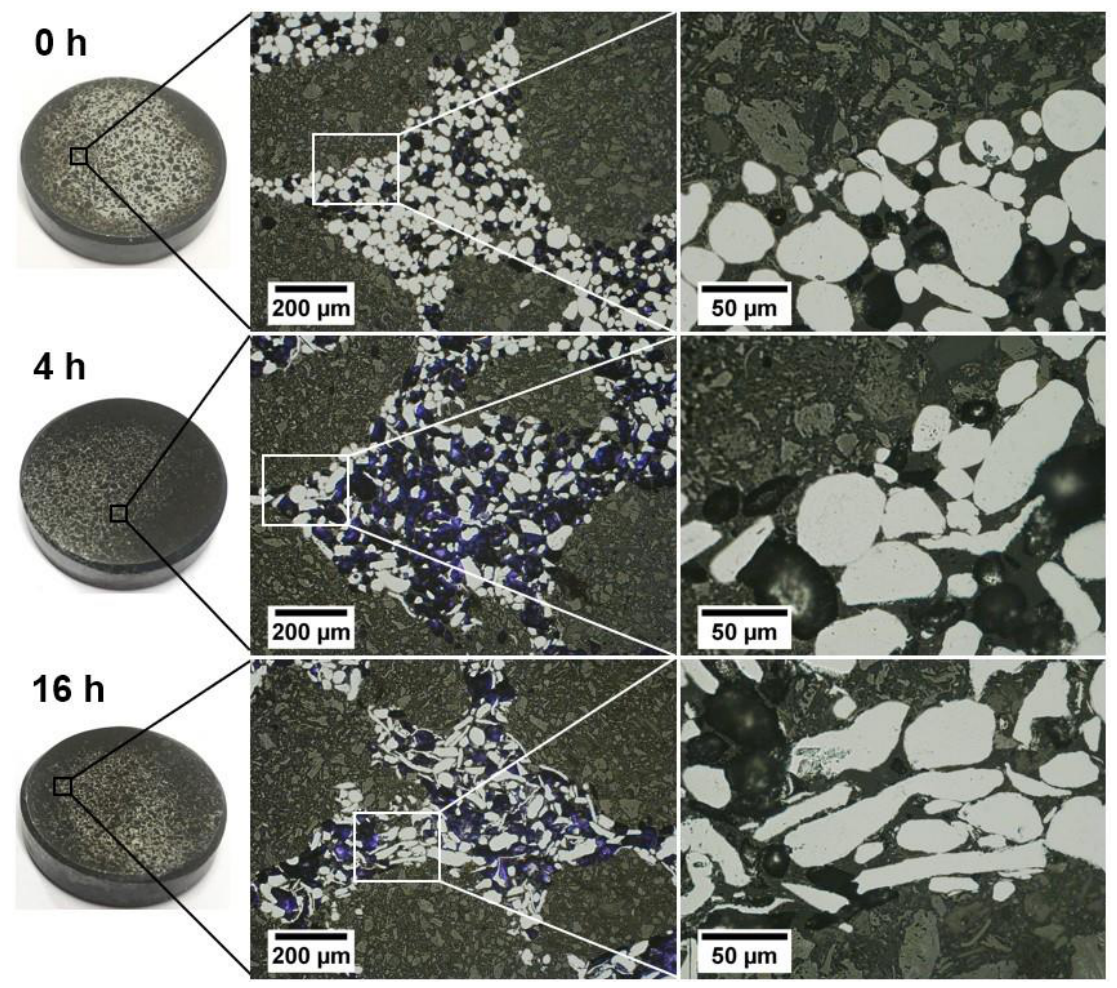
Figure 10. OM images of 0, 4 and 16 h milled powders.